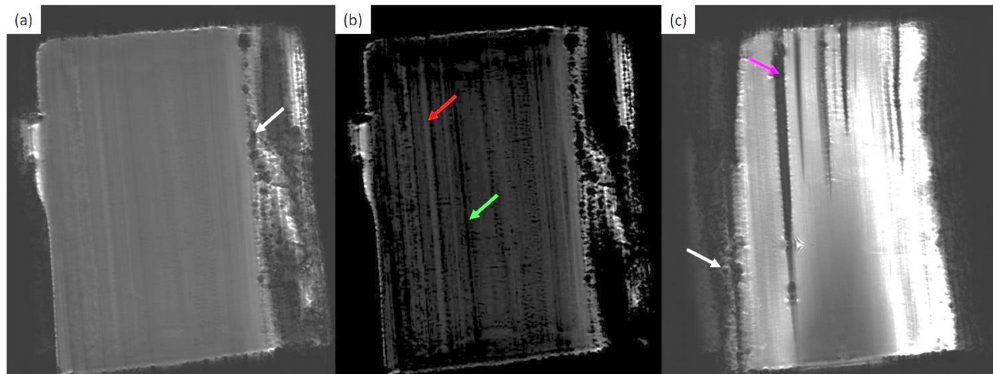
Figure 10. ( a ) T 2 *-weighted MR image of the longitudinal section of the archaeological wood sample cut from the heartwood area where the presence of decay (white arrow) is visible; ( b ) filtered longitudinal MR image to enhance the difference in contrast of the anatomical elements, such as vessels (red arrow) and the annual ring boundary (green arrow); ( c ) T 2 *-weighted MR image of the longitudinal section of the archaeological wood sample cut from the sapwood area where fractures (pink arrow) and decay (white arrow) are visible. The archeological wood sample is characterized by a diameter of 8.7 cm, and it is 12 cm long.